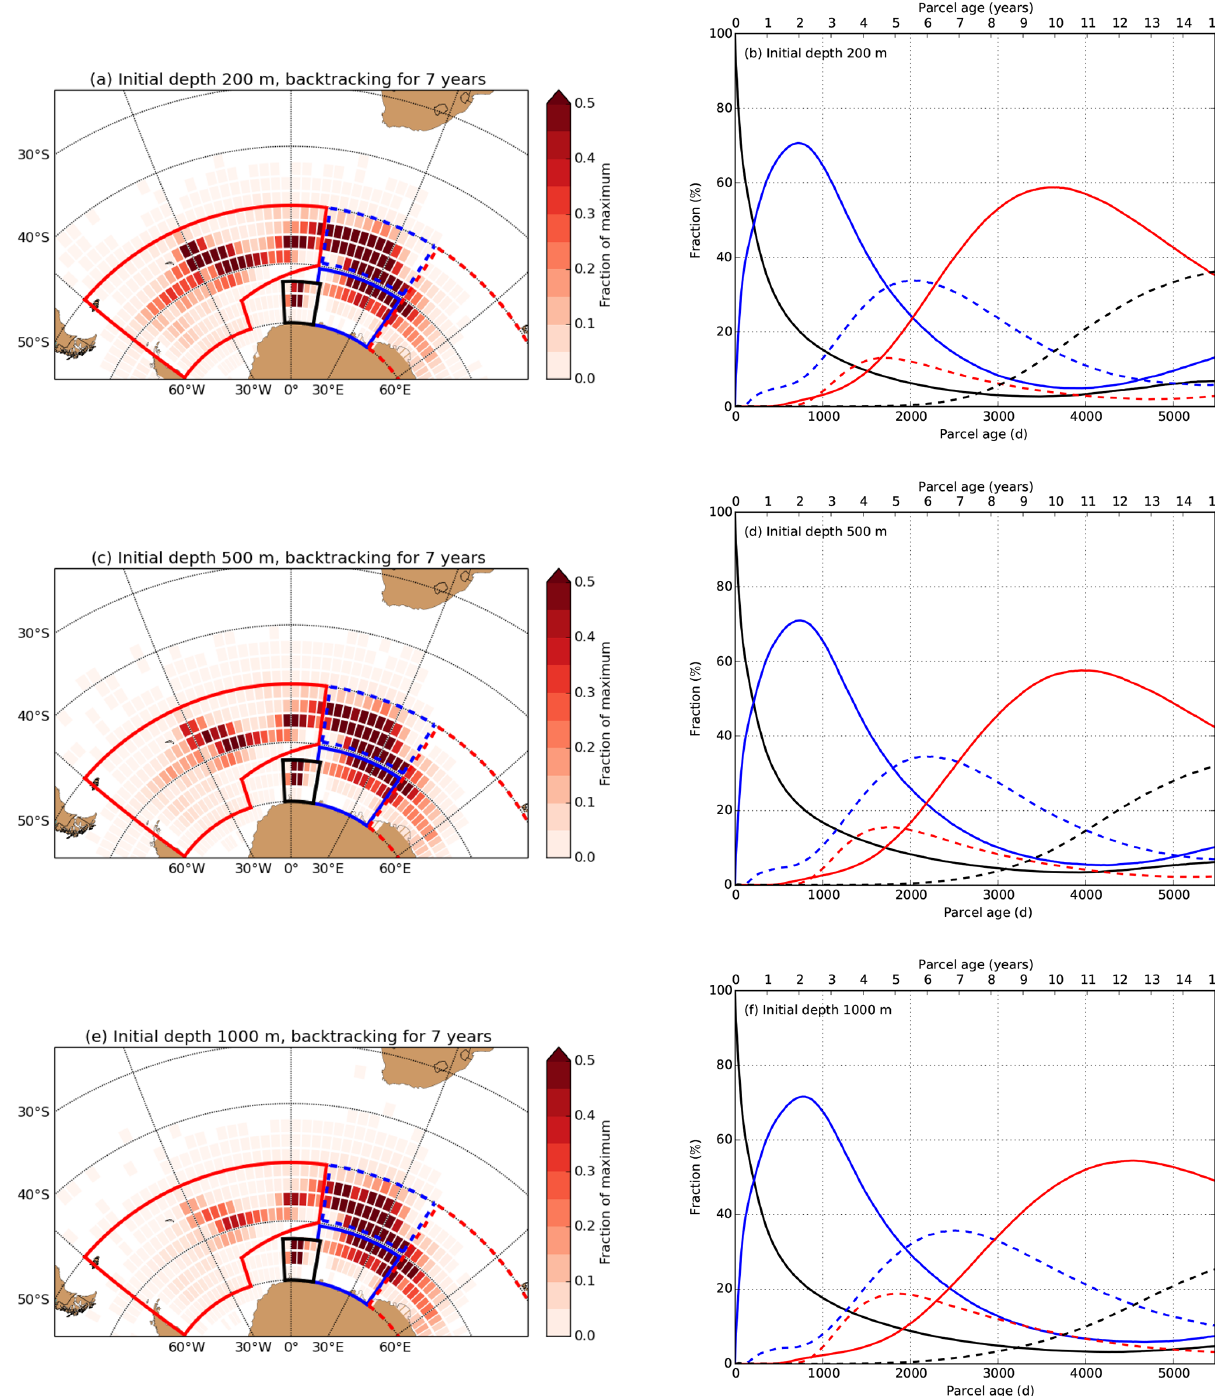
Figure 8. (a) Distribution of particles in the Southern Ocean after backtracking the particles for 7 years (80 months). The particles are initiated in the polynya region at 200m depth every 30d. The colour-coded regions are used in panel (b) , where the dashed red region has a zonal extent of 60 ◦ (40–100 ◦ E). (b) The time evolution of the fraction of particles in the colour-coded regions (see panel a ). The dashed black curve are particles outside the defined regions. (c–f) Similar to panels (a) and (b) , but the particles are initially released at 500 and 1000m depths in the polynya